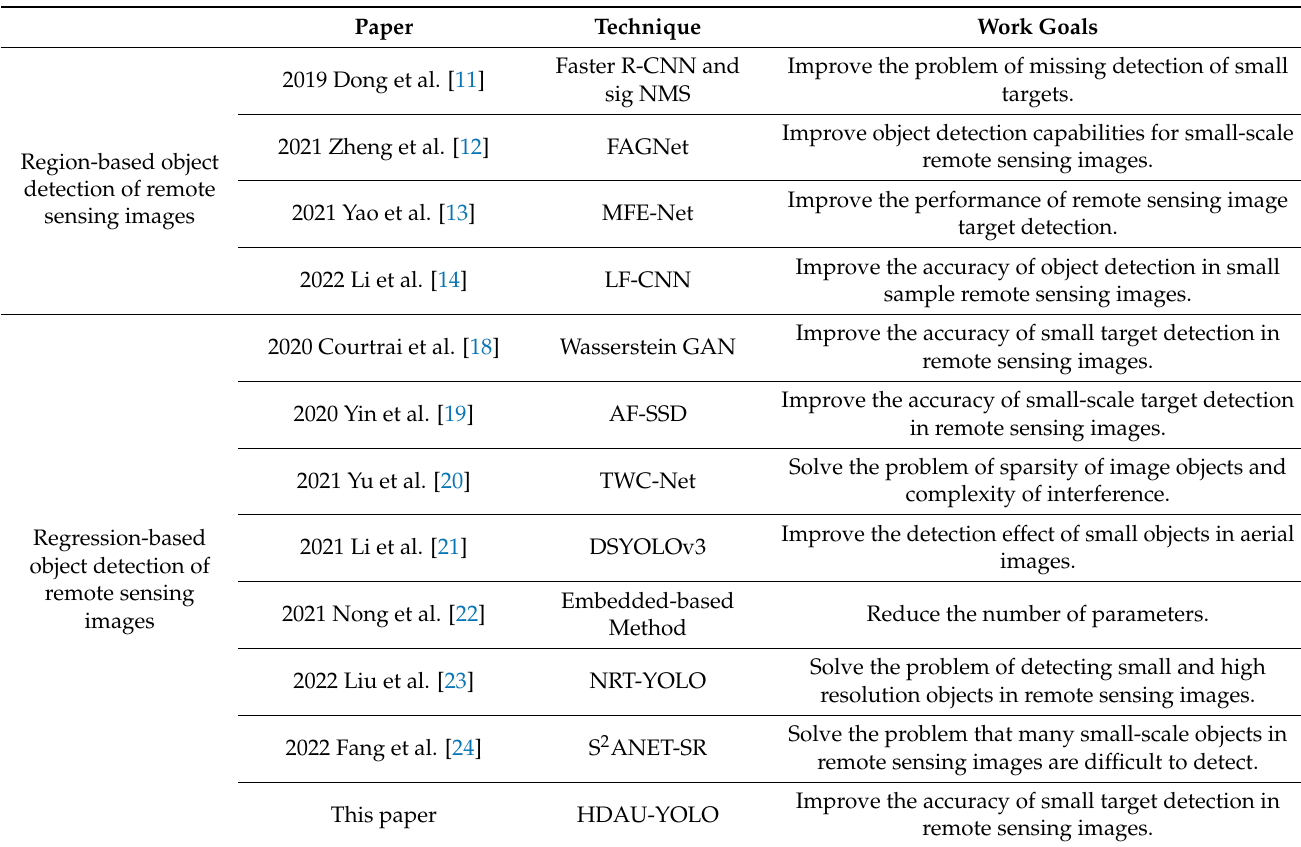
Table 1. The related work